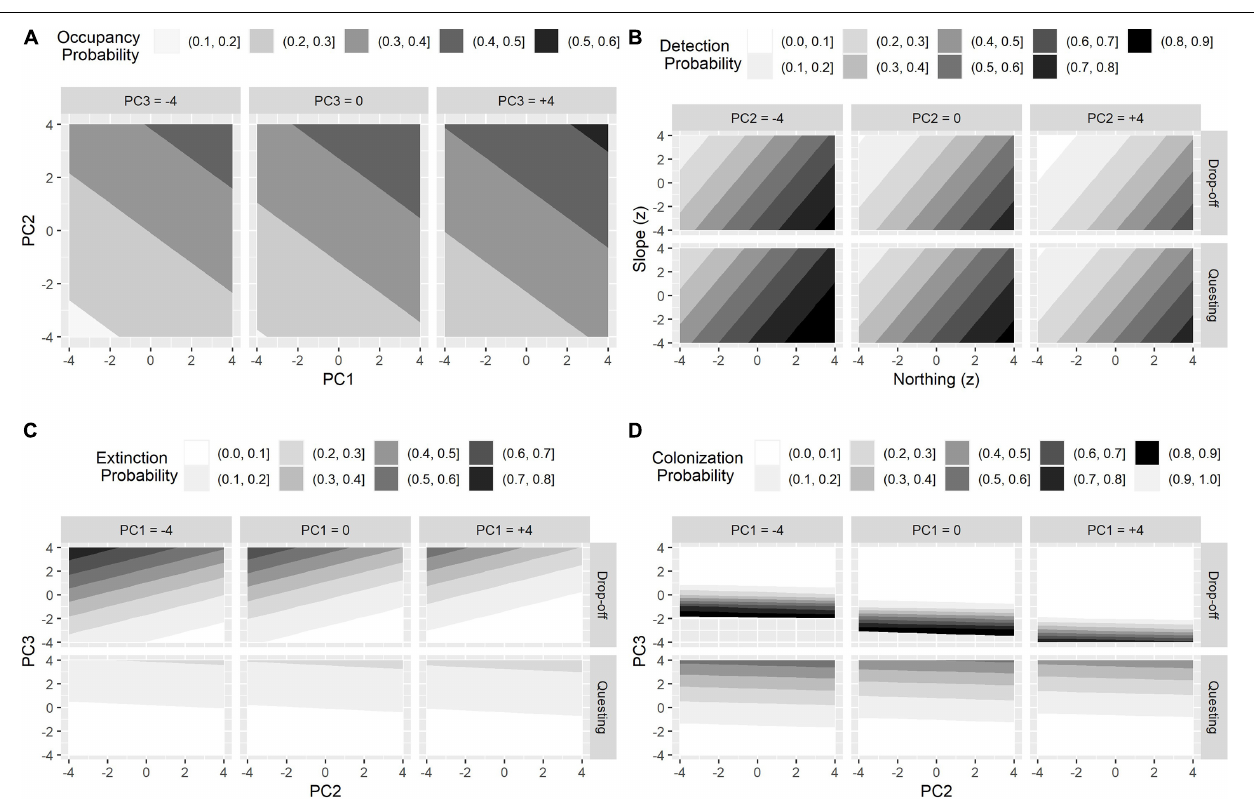
FIGURE 5 | The influence of top principal components on the probabilities of initial occupancy (A) , detection (B) , extinction (C) , and colonization (D) for female moose ( Alces alces ; n = 74) during two important winter tick ( Dermacentor albipictus ) periods (i.e., questing and drop-off) in northeastern Vermont, United